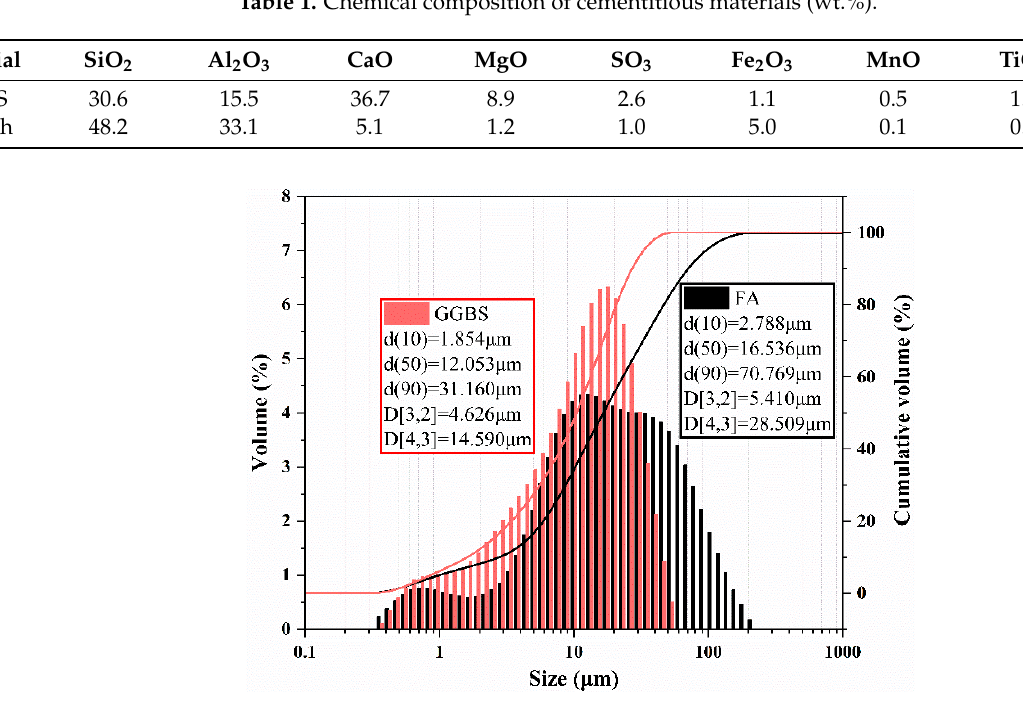
Table 2. Mix proportions of GGBS/ fl y ash pastes.